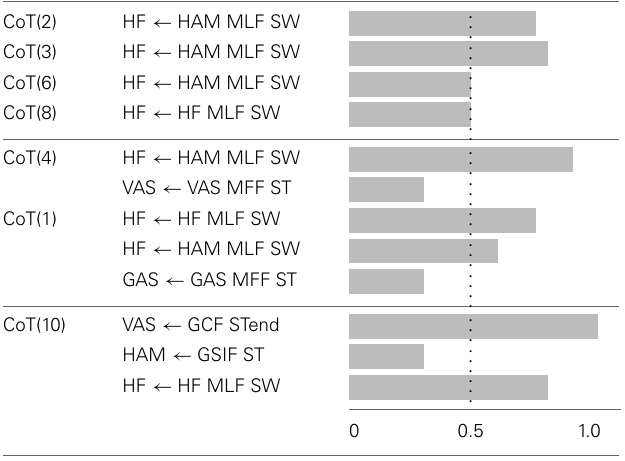
normalize the length of the vectors to 1000 points. The average of the normalized vector was then correlated with average human data. In (E) the subscripts show the compared muscles: (i) adductor longus, (ii) upper gluteus maximum, (iii) vastus lateralis, and (iv) semimembranosis. Note that the data was extracted from a model walking on a flat terrain without noise and external perturbations. Therefore, the standard deviation of the angles and torques trajectories and muscles activities is very small and thus not visible.